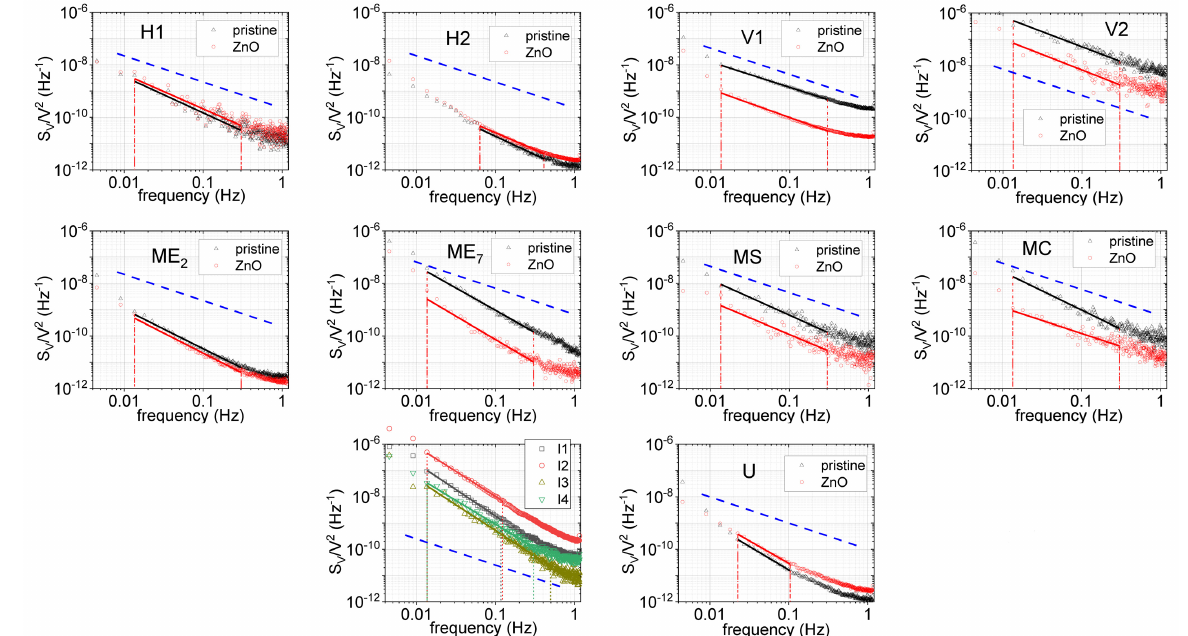
Figure 5. Normalized ( S V / V 2 ) noise data, plotted vs. frequency and for each device: Pristine graphene devices are plotted with black triangles, functionalized devices are plotted with red circles. The four interdigitated devices of pristine graphene I 1 –I 4 are also shown. A linear fit to a portion of the power spectrum, and the frequency range over which it was calculated, is shown for each data set. A representative 1/ f line is also shown on each graph as a blue dashed line; the vertical placement is arbitrary, with no